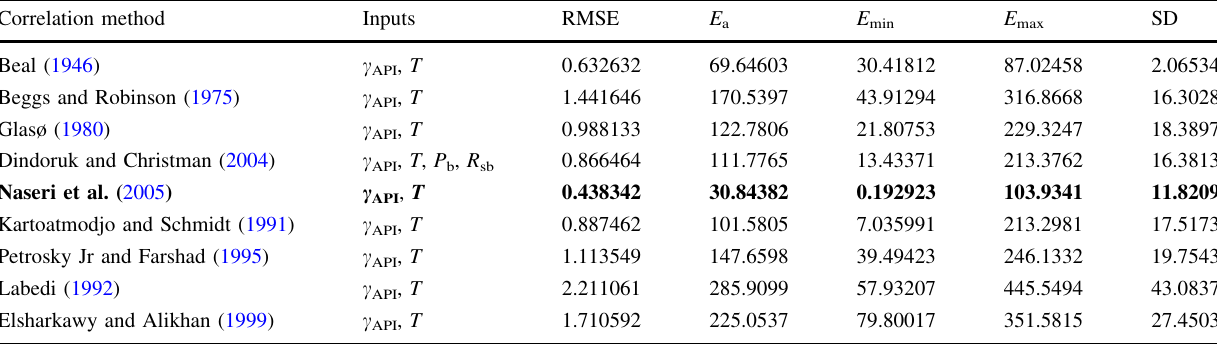
Table 6 Performance of l od empirical correlations